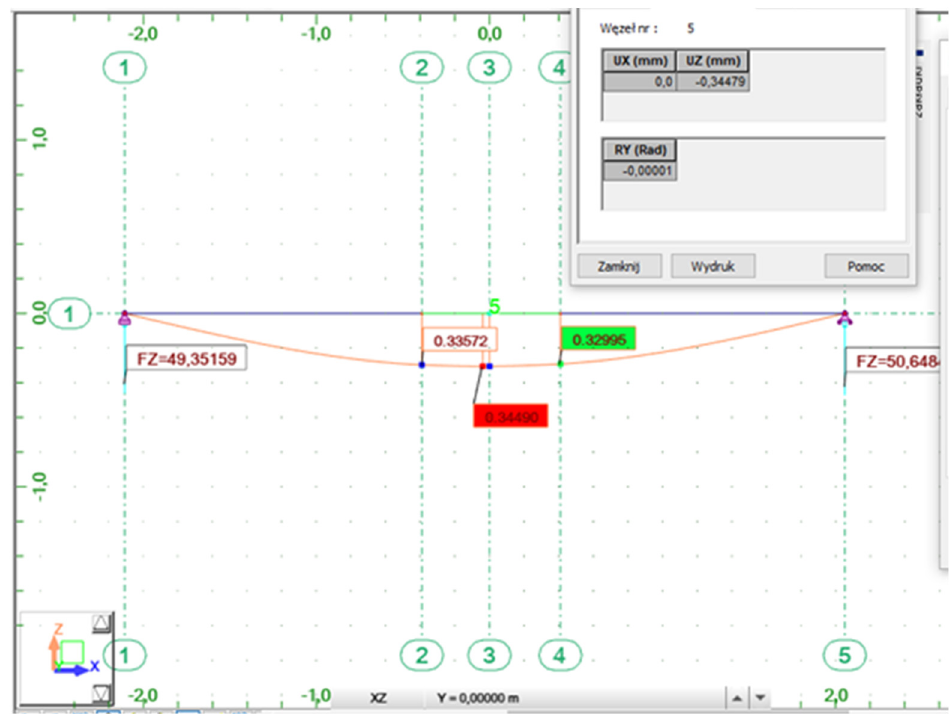
Figure 16. Shape of the deflected beam with an increased stiffness in the central part. Point load equal to 100 kN.